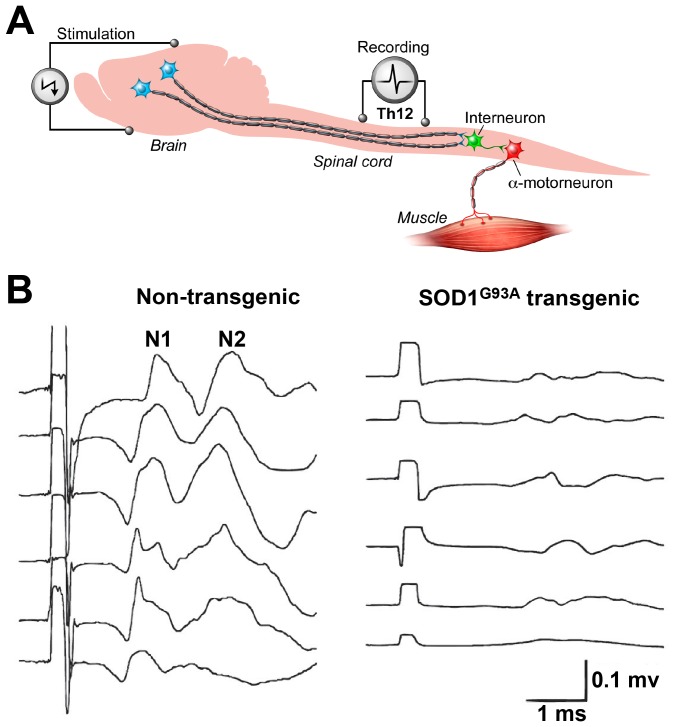
Motor-evoked potentials recorded from the dorsal surface of T12 spinal cord are near completely lost in endstage SOD1G93A rats.To identify the conductivity of descending motor axons MEPs were elicited by electrical stimulation of motor cortex and extra-pyramidal system and responses recorded from exposed T12 spinal segments (A). Recordings in 6 non-transgenic animals showed consistent compound action potentials consisting of N1 and N2 waves with an average latencies of 1.6–2.8 ms respectively (B). In contrast, recording in 6 transgenic SOD1G93A endstage animals showed near complete loss of N1 and N2 waves.